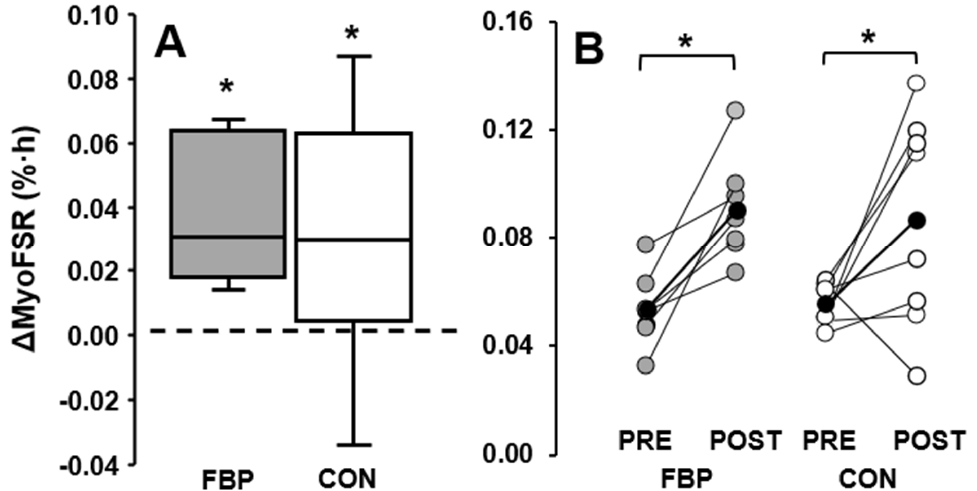
Figure 4. Post-exercise postprandial myofibrillar fractional synthetic rate (myoFSR) change (%·h − 1 ) for fava bean protein (FBP) and control (CON) groups. ( A ), change values (post-test – pre-test) boxplot. ( B ), pre-test (PRE) to post-test (POST) values; data are individual participants from fava bean protein (FBP, grey circles), control (CON, white circles) groups; group means (black circles). * Indicates a change from PRE ( p <